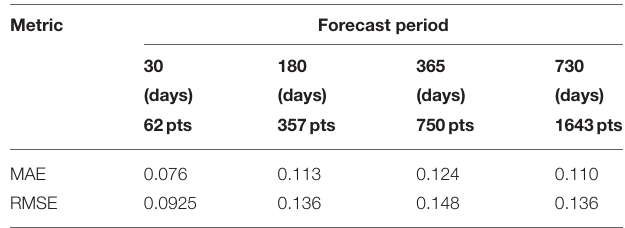
TABLE 2 | Evaluation of forecast accuracy for the different forecast periods on the piezometric pressure data.